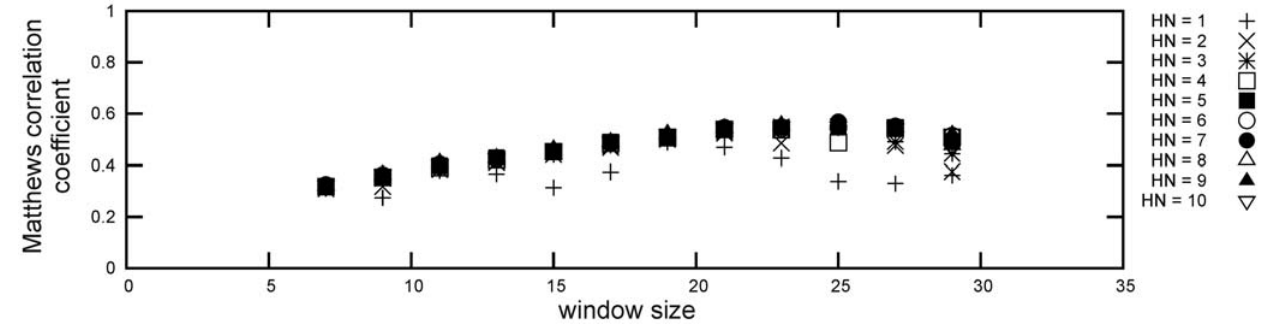
Figure 3. T3SS effector proteins contain a targeting signal in their N-terminal sequence portion. Performance results of the first round of neural network cross-validation for sequence length 30 and varying numbers of hidden neurons (HN) in the neural network classifiers and window sizes are shown. Values are averaged over the cross-validation folds. The data for lengths 10, 20, 40 and 50 can be found in Supplementary Figure S1.